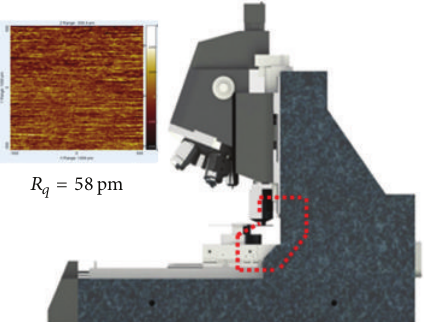
Figure 4: The illustration of the mechanical loop in the AFM. The mechanical loop in sequence consists of the sample, the sample chuck, the stage, the linear guides, the granite base, the granite arch, the approach stage, the scanner body, and the cantilever tip. Test image for noise floor measurement is shown in the insert. The 𝑧 - scale is ± 250 pm. The RMS noise is estimated to be